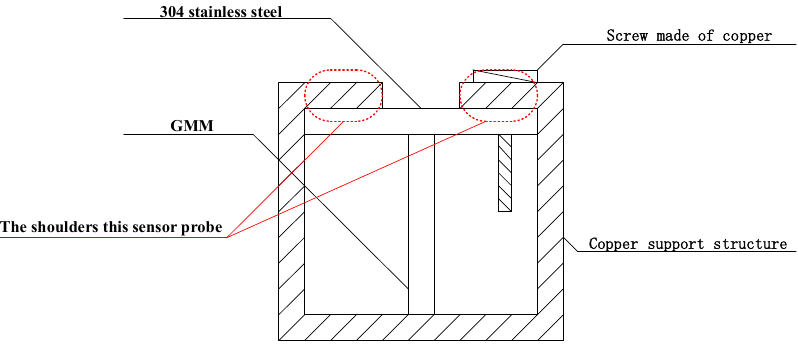
Figure 15. The shoulders of the external support structure of the sensor probe. The area enclosed by two red ovals is the shoulders of this sensor probe.